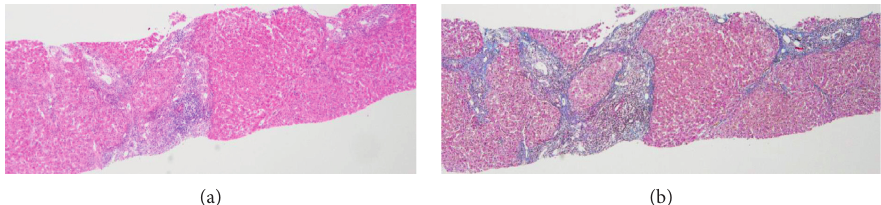
Figure 1: Histological findings of the liver biopsy specimen. (a) Moderate lymphocytic infiltrates in the portal areas of hepatic lobules with slightly piecemeal necrosis (hematoxylin and eosin staining; magnification, × 40). (b) Fibrous expansion of portal areas with occasional